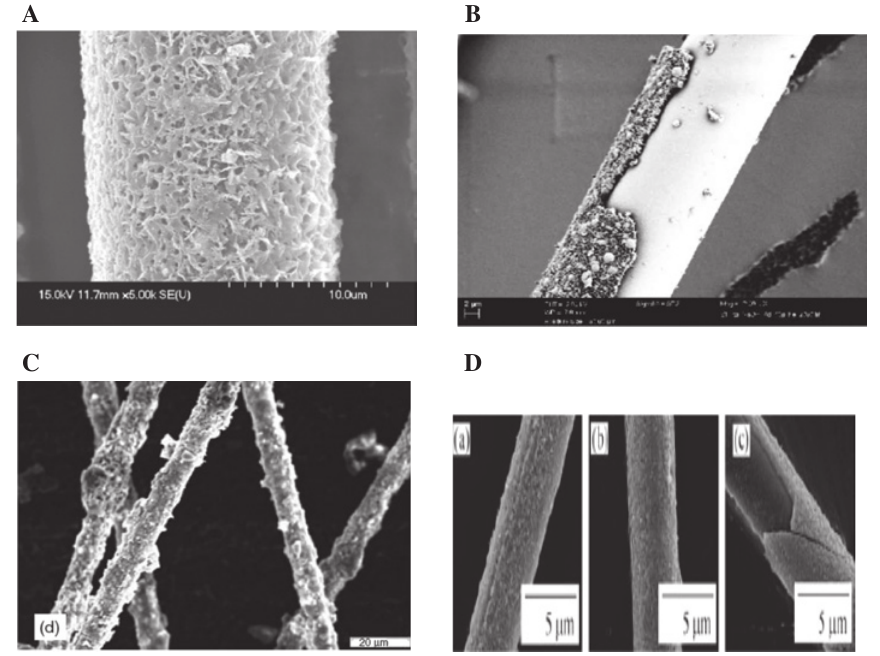
Figure 2: SEM image of basalt fiber after alkali treatment. (A) Treatment with NaOH [16], (B) Treatment with 5% NaOH [15], (C) Boiled with 2 mol/l NaOH [17], (D) 2 mol/l NaOH solution after 1 h, 6 h and 24 h